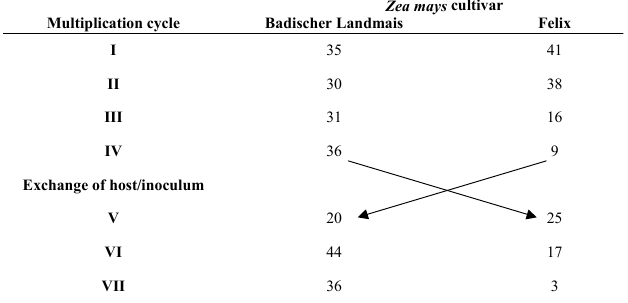
Fig. 3: Mycorrhizal Effectiveness [%] of Claroideoglomus etunicatum on Zea mays (varieties Badischer Landmais and Felix) over seven years of subsequent inoculum production. (The inoculum was exchanged after the fourth year; derived from F eLDmann ,